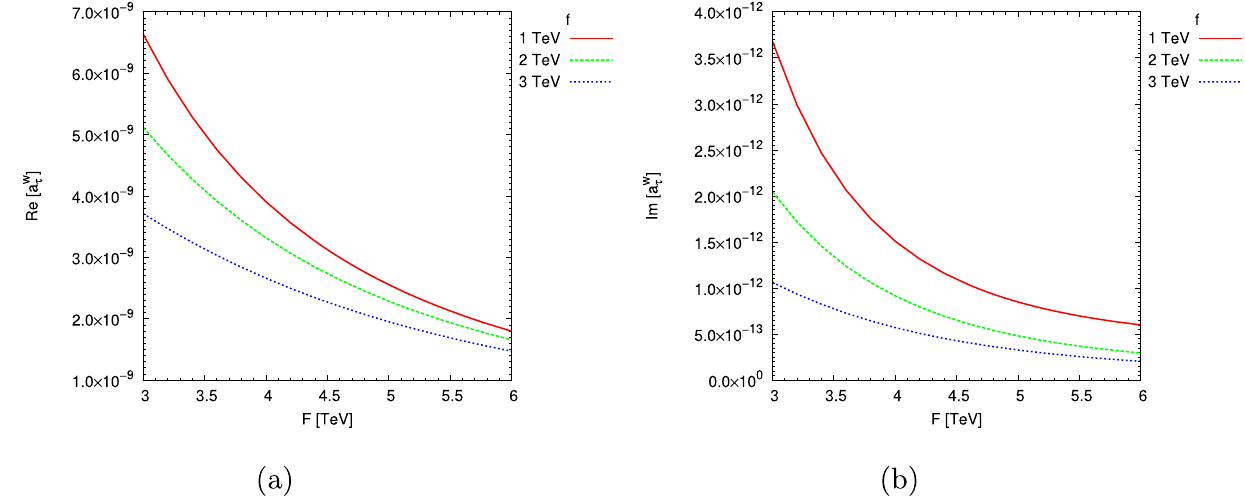
Fig. 10 Total contribution to a W τ for different values of the energy scale f . a Re( a W τ ). b Im( a W τ ). The plots are obtained for specific fixed values of the f scale. The values provided in Table 3 are used for the remaining parameters of the